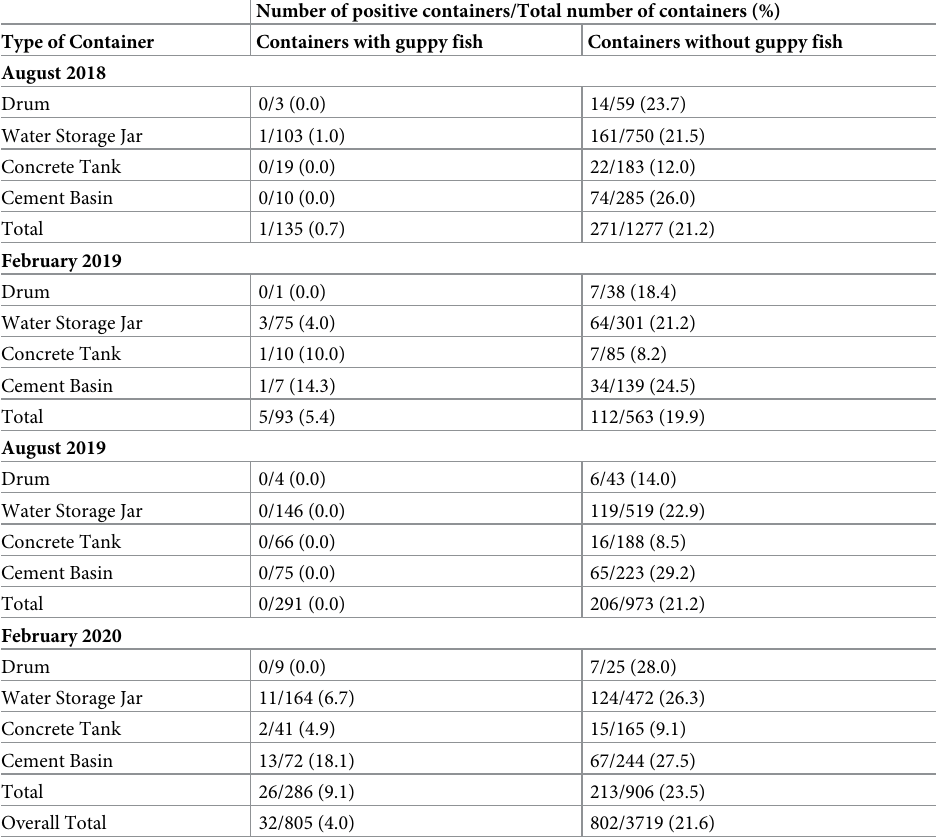
Table 6. Number and proportion of containers infested with mosquito larvae and/or pupae, by container type, whether or not the container contains guppy fish and survey time point. Number of positive containers/Total number of containers